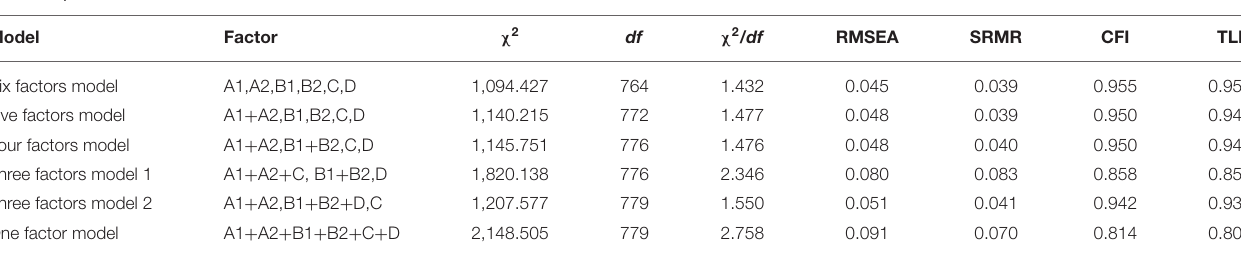
TABLE 2 | Fit indices of each